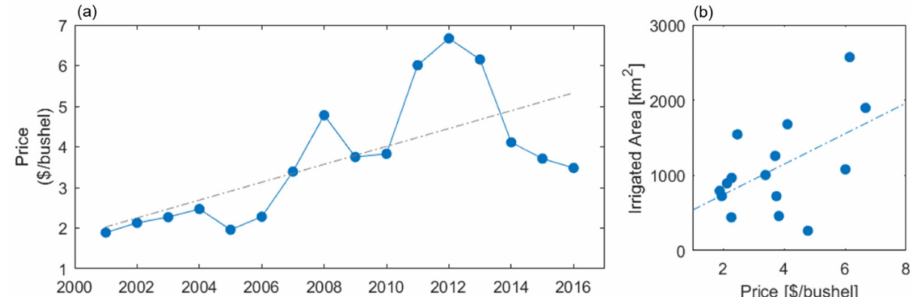
Figure 9. Commodity price of corn ( a ) and its correlation with irrigated area ( b )